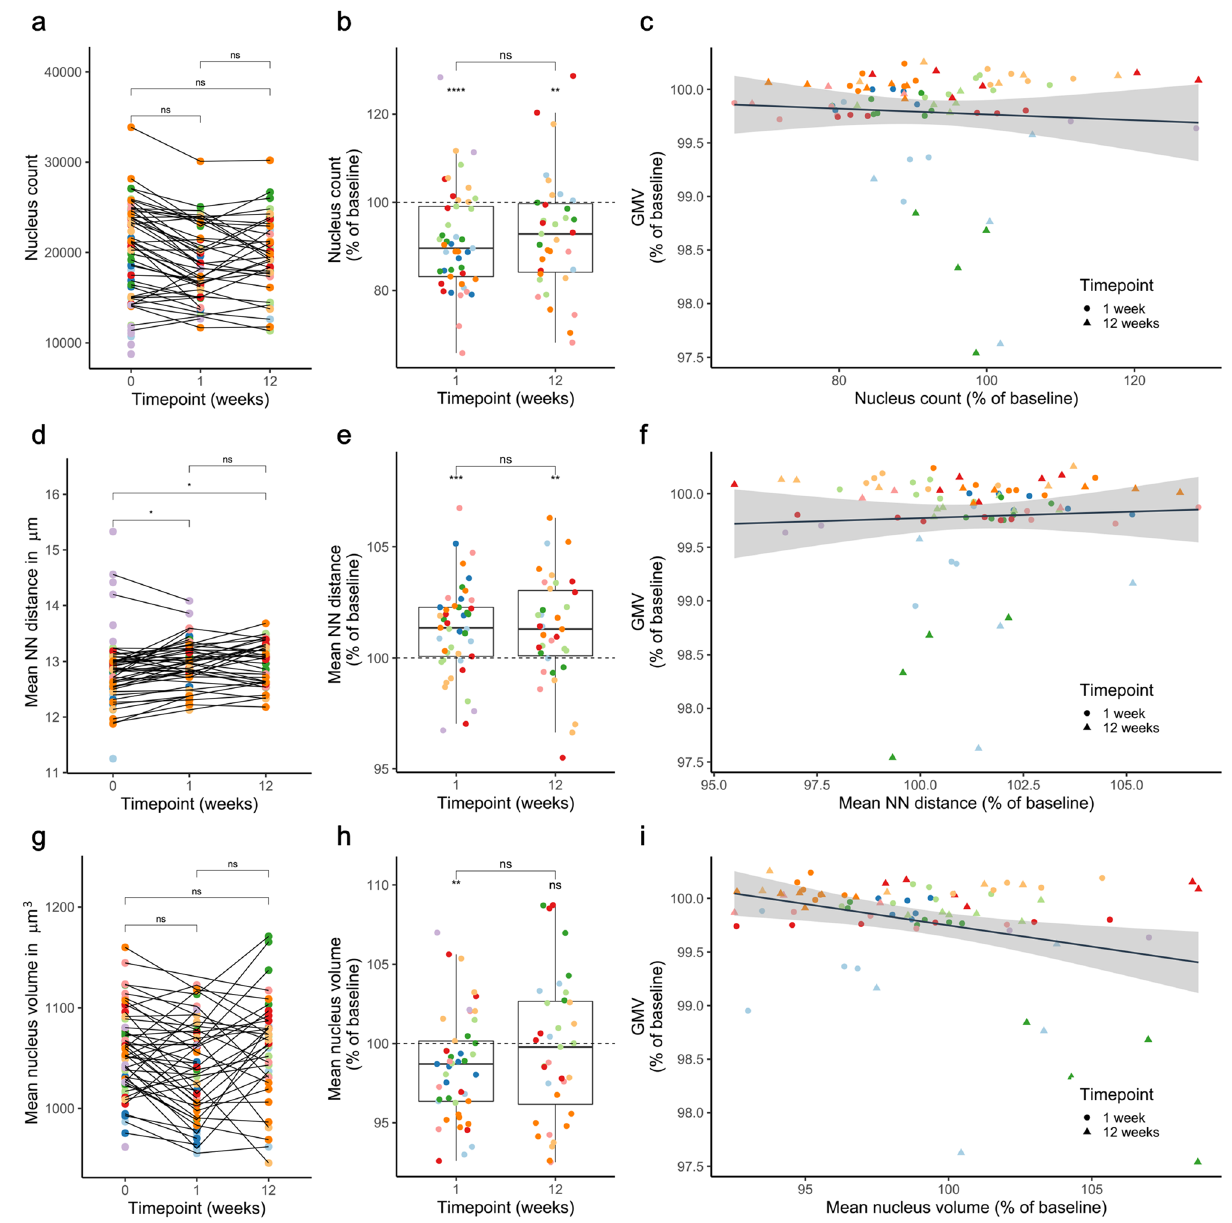
Figure 7. Correlations of GMV with cell number, nearest neighbour distance and mean nucleus volume. ( a , d,g ) n = 60 positions from 10 mice in week 0, 45 positions from 9 mice in week 1, 35 positions from 7 mice in week 12. ( b , c , e , f , h , i ) At 1 week: n = 45 positions from 9 mice; at 12 weeks: n = 35 positions of 7 mice. ( a ) Number of cells within the whole 2Pii stack as counted by automated detection. Mean ± SD over all 2Pii stacks is given in thousands: baseline = 19.50 ± 5.46; 1 week = 18.70 ± 4.31, 12 weeks = 19.77 ± 4.31. Linear mixed effect model with pairwise contrasting and correction for multiple comparison: week 1 vs. baseline: p = 0.12, week 12 vs. baseline: p = 0.55, week 12 vs. week 1: p = 0.73. ( b ) Relative change in the number of cells compared to baseline. Mean ± SD over all 2Pii stacks is given in % of baseline: 1 week = 91.26 ± 11.70; One sample t test gives p < 0.001, DF = 44, t = -5.009. 12 weeks = 92.72 ± 13.30; one-sample t test gives t = -3.24, DF = 34, p = 0.003. Linear mixed effect model for difference between 1 and 12 weeks: p = 0.430. ( c ) Correlation of GMV change and change of cell count. Linear mixed effect model: p = 0.303. ( d ) Mean nearest neighbour distance. Mean ± SD over all 2Pii stacks in µm: baseline = 12.89 ± 0.67; 1 week = 12.97 ± 0.42, 12 weeks = 12.96 ± 0.39. Linear mixed effect model with pairwise contrasting and correction for multiple comparison: week 1 vs. baseline: p = 0.030, week 12 vs. baseline: p = 0.025, week 12 vs. week 1: p = 0.950. ( e ) Relative change in nearest neighbour distances compared to baseline. Mean ± SD over all 2Pii stacks is given in % of baseline. 1 week: = 101.27 ± 2.05; one-sample t test gives t = 4.145, DF = 44, p < 0.001. 12 weeks = 101.27 ± 2.39; one-sample t test gives t = 3.156, DF = 34, p = 0.003. Linear mixed effect model for difference between 1 and 12 weeks: p = 0.871. ( f ) Correlation of GMV change with change of NN distance. Linear mixed effect model: p = 0.411. ( g ) Mean nuclear volume. Mean ± SD over all 2Pii stacks is given in µm 3 : baseline = 1054 ± 43; 1 week = 1039 ± 47; 12 weeks = 1060 ± 53. Linear mixed effect model with pairwise contrasting and correction for multiple comparison: week 1 vs. baseline: p = 0.167, week 12 vs. baseline: p = 0.962, week 12 vs. week 1: p = 0.155. ( h ) Relative change in mean nucleus volume compared to baseline. Mean ± SD over all 2Pii stacks is given in % of baseline. 1 week = 98.54 ± 3.34; one-sample t test gives t = -2.93, DF = 44, p = 0.005. 12 weeks = 99.67 ± 4.59; one-sample t test gives t = -0.43, DF = 34, p = 0.670. Linear mixed effect model for difference between 1 and 12 weeks: p = 0.080. ( i ) Correlation of GMV and mean nucleus volume. Linear mixed effect model: p = 0.002, Estimate = − 0.039%, R 2 =